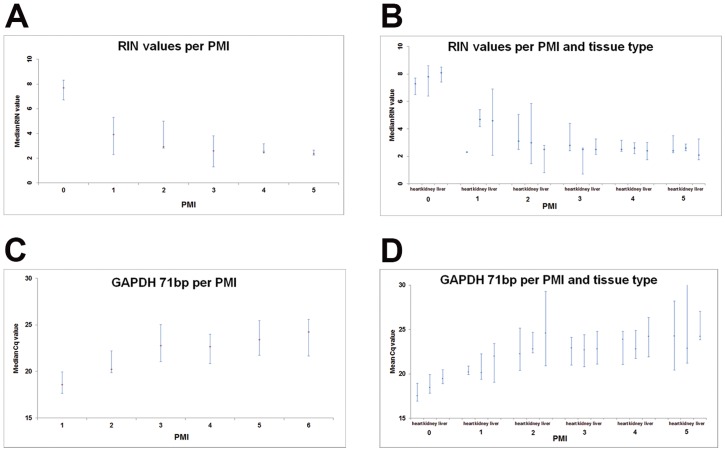
RNA integrity and GAPDH expression versus post-mortem intervals in MIA and CA samples.In Figs. 3A and B the median RIN value (X-axis) decreases with the post mortem interval (PMI; Y-axis). The fresh frozen specimens (PMI  = 0) show the highest RNA integrity. PMI 1 is exclusively comprised of MIA samples. PMI 2 to 5 are comprised of both MIA and CA samples. The actual PMI intervals are given in table 3. In Figs. 3C and D the results of RT-qPCR with GAPDH 71 bp are shown in the same context. Here we can appreciate that RT-qPCR is a more sensitive method of RNA integrity measurement, since it was possible to find significant differences not only between PMI 0 and PMI 1, as was also measured with RIN values, but also between PMI 1 and PMI 2.